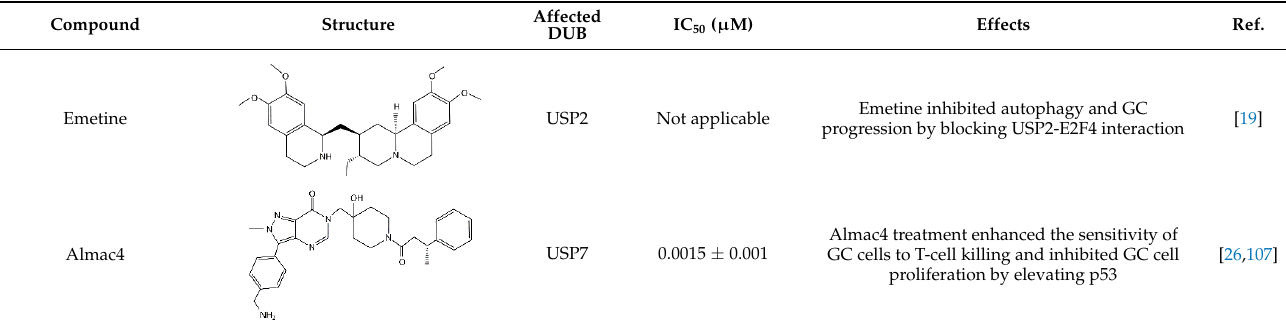
Table 2. Compounds that suppress GC by modulating DUBs.